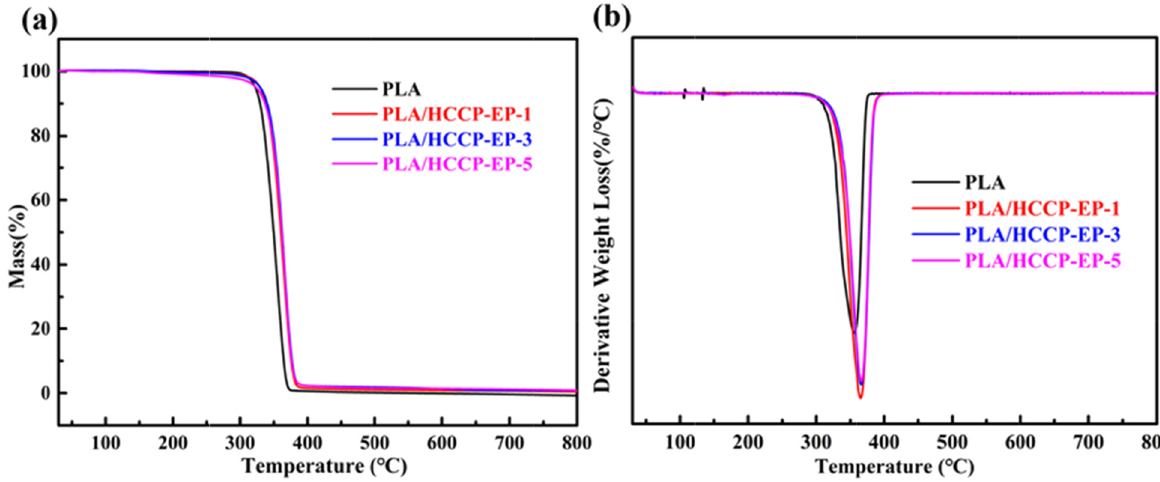
Figure 10: ( a ) TG and ( b ) DTG curves of PLA/HCCP - EP